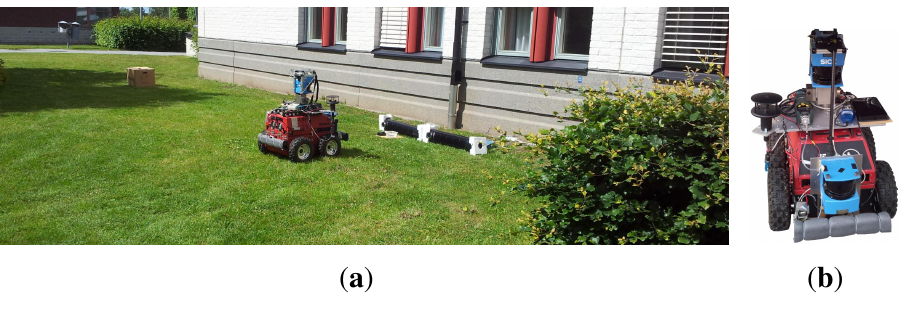
Figure 5. ( a ) Outdoor courtyard. ( b ) ATRV-JR